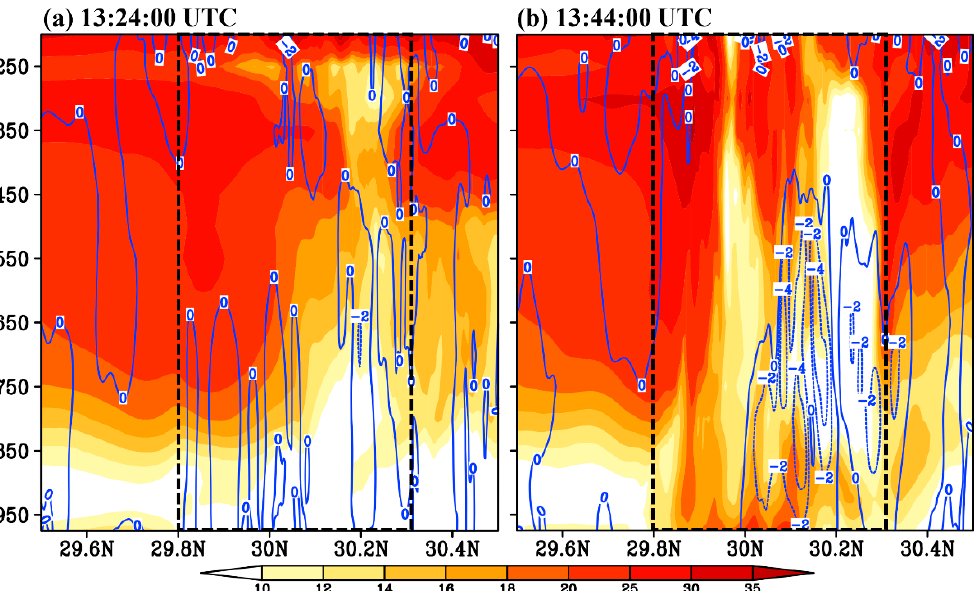
Figure 13. Panels ( a , b ) show the averaged (from 120.24° E to 120.32° E) cross section of the horizontal wind speed (shading; m s − 1 ) and descending motions (blue contour; m s − 1 ) at typical stages, where the black dashed lines mark the key region. The ordinate is pressure and the abscissa is latitude.